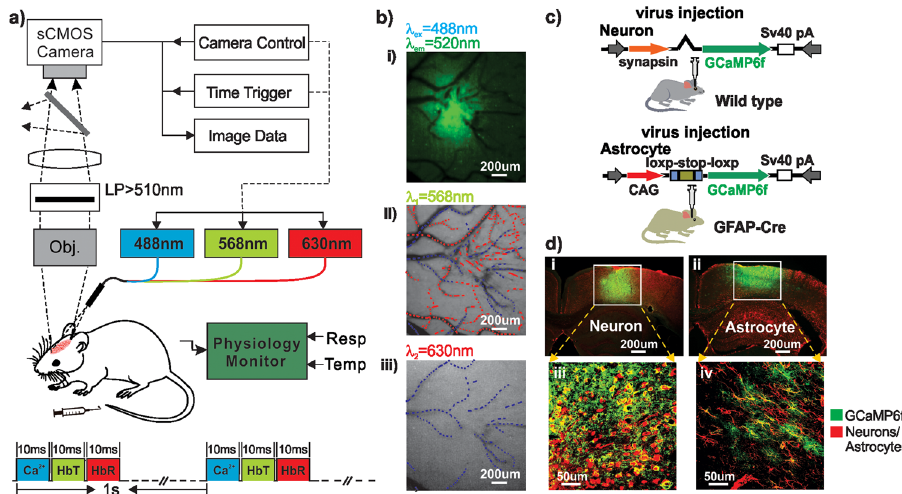
Fig. 1 A schematic illustration of the experimental design and animal models. a Multimodality imaging platform allows simultaneous imaging of cellular Ca 2 + dependent fl uorescence and hemodynamic changes in response to cocaine. LP: Long-pass fi lter >510 nm. b Cortical images acquired with the different channels including fl uorescence image (i: λ ex = 488 nm, λ em = 520 nm), re fl ected images at λ 1 = 568 nm (ii) and λ 2 = 630 nm (iii) to separate arteries (red tracks) from veins (blue tracks) and to retrieve hemodynamics (HbO 2 and HbR) in brain tissue. c Animal models for viral delivery of GCaMP6f to neurons and astrocytes to mouse somatosensory cortex in vivo. d Ex-vivo confocal fl uorescence images to show GCaMP6f distribution in cortical neurons (i) and astrocytes (ii), respectively. Zoomed-in views to con fi rm GCaMP6f-expressions in neurons (iii) and astrocytes (iv) within the white boxes. Green: GCaMP6f-expressing neurons and Red: NeuN (iii), Green: GCaMP6f-expressing astrocytes and Red: GFAP stains (iv) to represent neurons and astrocytes, extracted. Figure 2c, d show Δ [HbT-G(N)] and Δ [HbT-G(A)] changes with time after cocaine (1 mg/kg, i.v.), respectively, which reveals that total blood volumes in arteries and veins decreased immediately ( Δ t = 2 min) after cocaine to ~ − 20%( t = 5 – 10 min) below their baseline followed by gradual recovery. Meanwhile, Fig. 2e, f show Δ [ Φ -G(N)] and Δ [ Φ -G(A)] changes as a function of time from cocaine injection (1 mg/kg, i.v.), respectively, which indicate that vessel sizes of arteries and veins decreased to ~ − 10% ( t = 0 – 20 min) and slowly returned to baseline within t = 60 mins. The mean Δ [HbT] decay rates ( Δ [HbT]%/min) are summarized in Fig. 2g for neuronal- (Group N) and astrocytic- GCaMP6f expressing (Group A) mice. For Group N, Δ [HbT-G(N)]%/min in